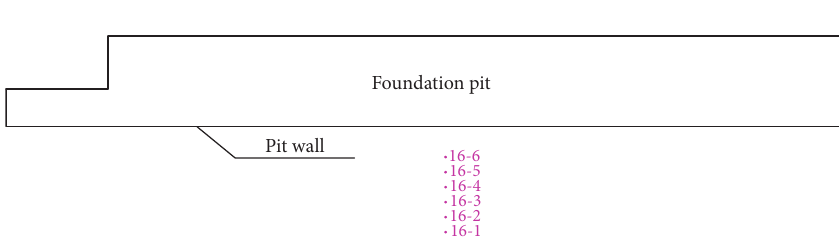
Figure 8: Schematic diagram of the ground subsidence monitoring points around the foundation pit.